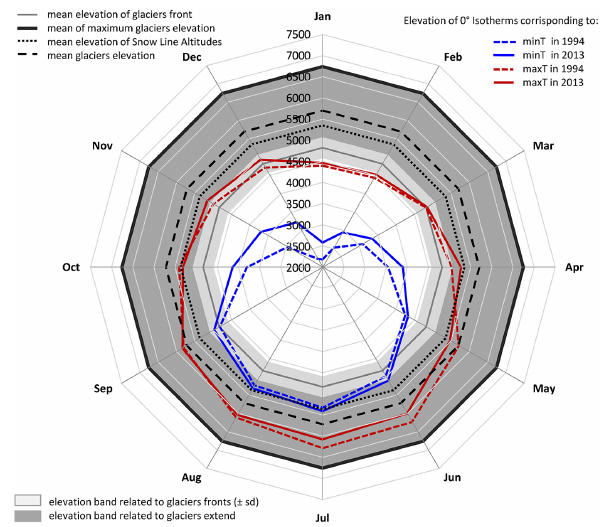
Figure 8. Linkage between the temperature increases and altitudinal glacier distribution. The 0 °C isotherms corresponding to the mean monthly minimum and maximum temperature are plotted for the 1994 and 2013 years according the observed T trends and lapse